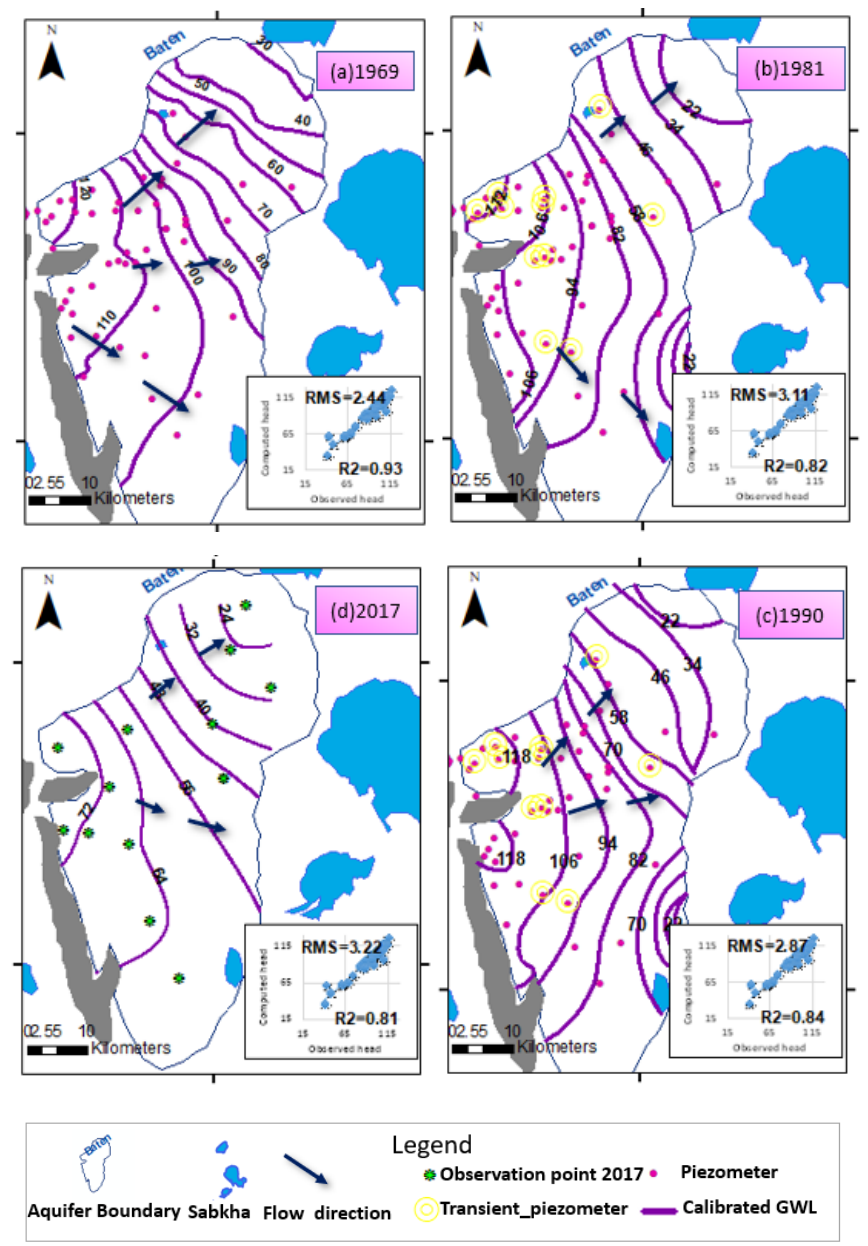
Figure 8. Calibrated Groundwater level (CGWL) and scatter plot (observed vs. simulated), RMS (Root Mean Square error) and R 2 (Correlation coefficient) ( a ) in 1969 (steady state), ( b ) in 1981 (before dam construction), ( c ) in 1990 (after dam construction), ( d ) in 2017 (actual measurement).